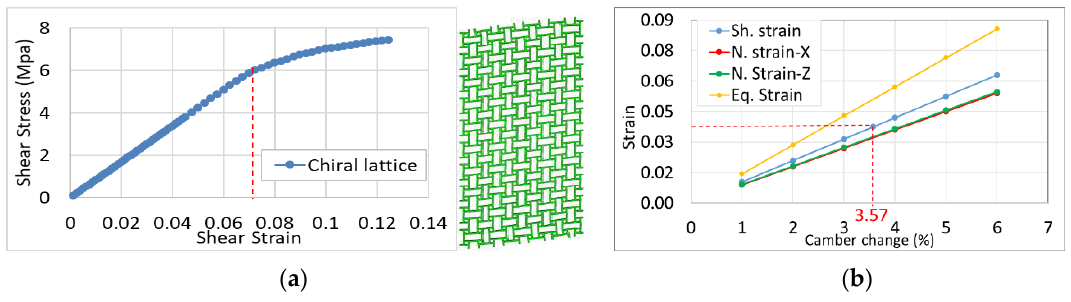
Figure 13. ( a ) In-plane shear stress/strain curve and ( b ) percentage of camber change vs. corresponding strain.